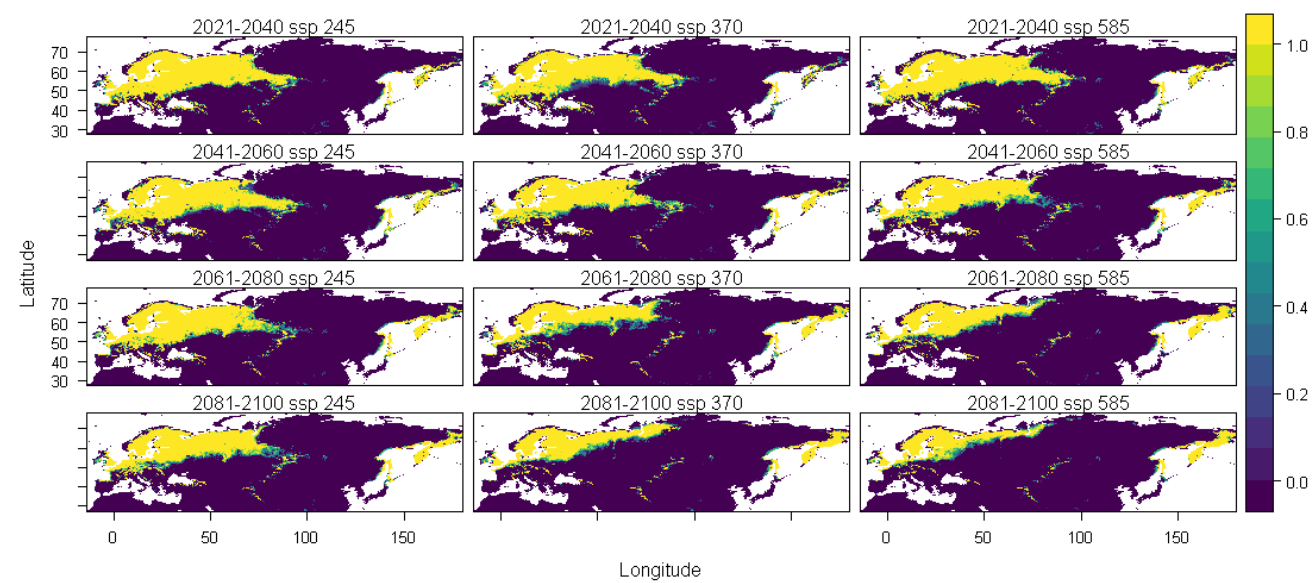
Figure 2. Average prediction of climate habitat suitability maps for Sympetrum flaveolum under future climate scenarios. Average projections are presented for each of four time periods (2021–2040, 2041–2060, 2061–2080, and 2081–2100) and three shared socioeconomic pathways (optimistic—SSP245, middle of the road—SSP370 and worst—SSP585). The probability of occurrence ranges from 0 (dark purple, low probability) to 1 (yellow, highest probability).